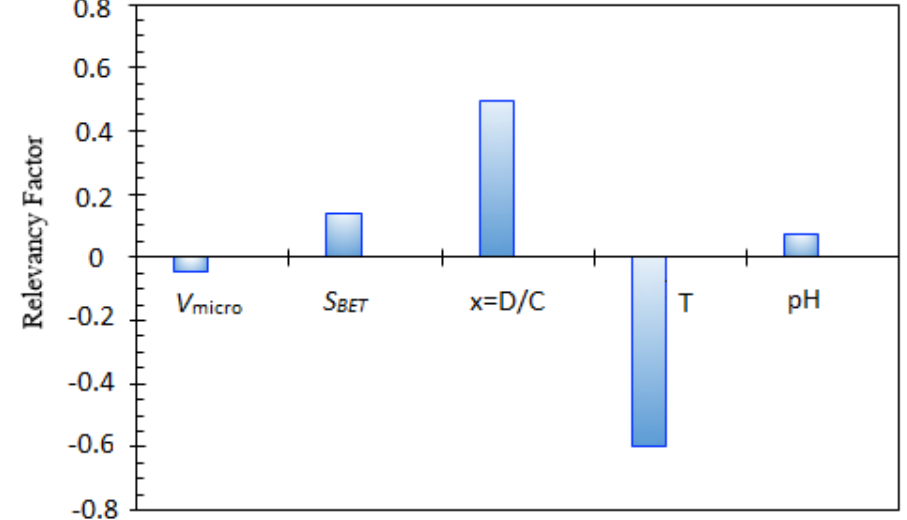
Figure 14. Relative contribution of various input variables in asphaltenes adsorption.